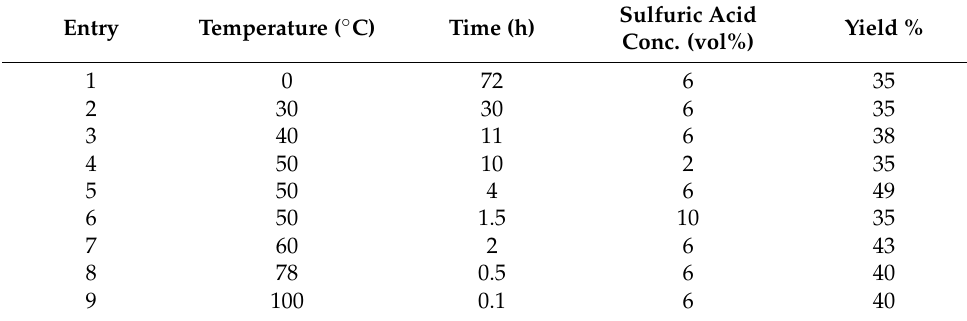
Table 1. Optimization of the acetolysis of per acetyl- α